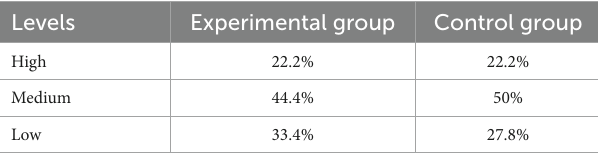
TABLE 1 Table of mean students’ critical thinking